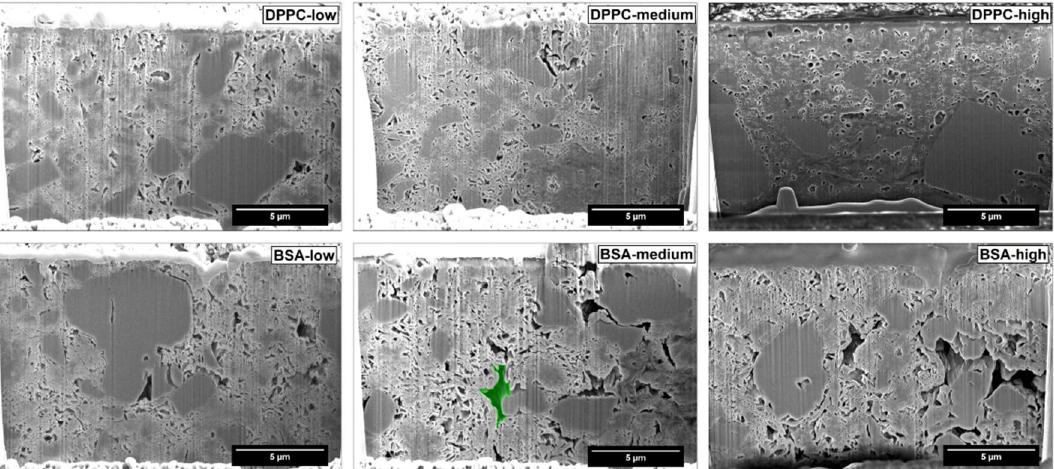
Figure 4. Analysis of consolidated FCC particles loaded with DPPC or BSA. Particles loaded with DPPC ( top row ) or BSA ( bottom row ) were analyzed by FIB-SEM. Mercury intrusion porosimetry results for the same material are shown in Figure 2. An example showing an interparticulate void is highlighted in green.